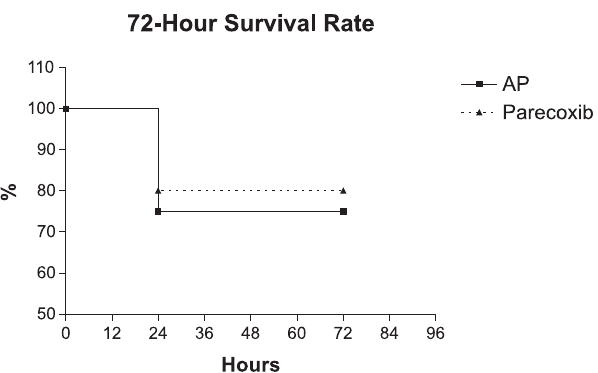
Figure 4 - Effect of Cox-2 inhibition on mortality rate, showing a better late survival rate in parecoxib-treated rats, but with no significant difference between the groups (Chi square = 0.1398; P = 0.7085; n =